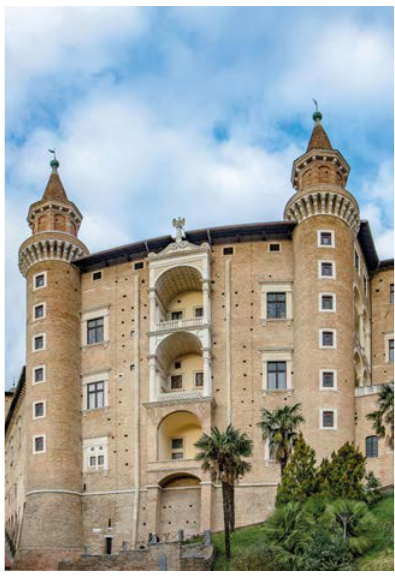
Figure 1 – The Palazzo Ducale of Urbino. Photo by Manuele